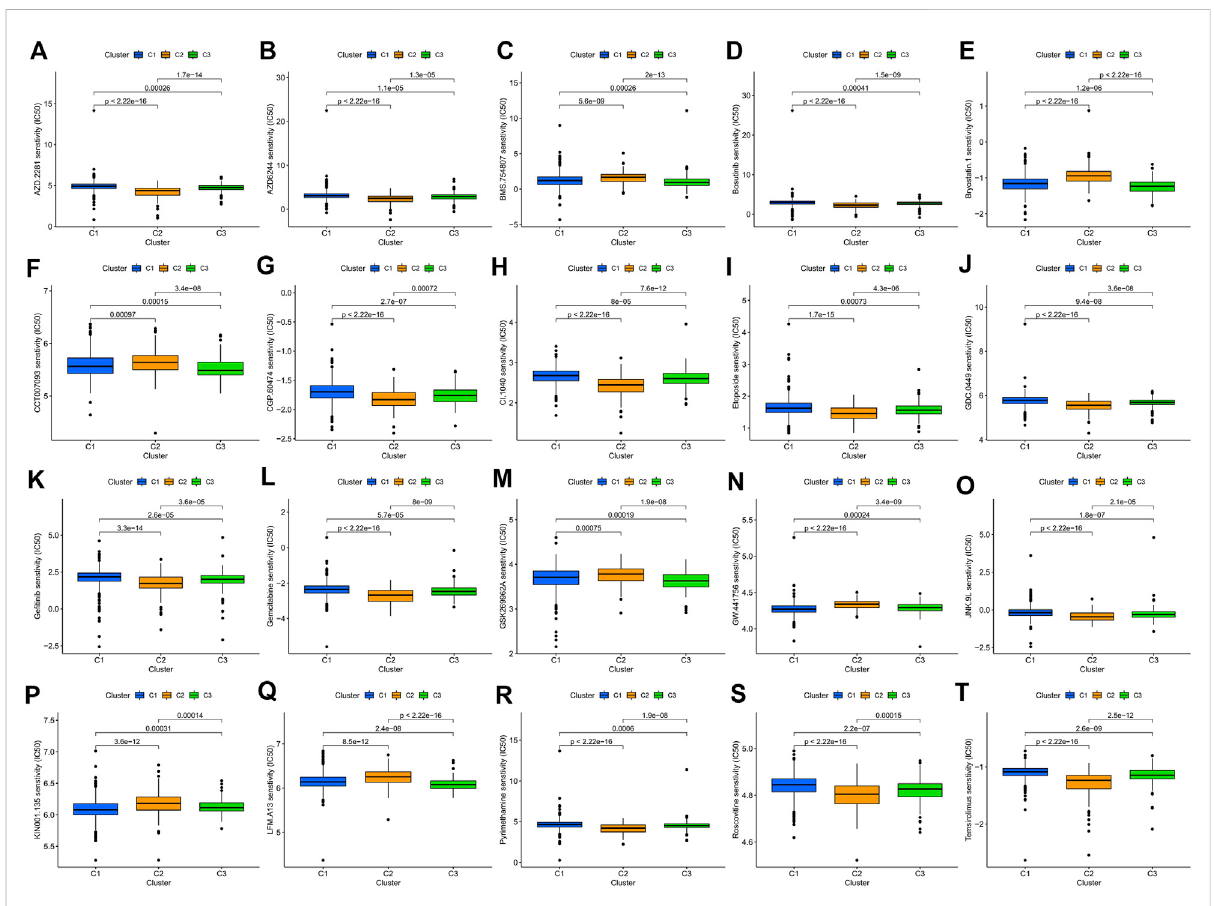
FIGURE 9 Comparison of potential therapeutic drug susceptibility among the three different subgroups as assessed by IC50. (A) AZD.2281. (B) AZD6244. (C) BMS.754807. (D) Bosutinib. (E) Bryostatin.1. (F) CCT007093. (G) CGP.60474. (H) CI.1040. (I) Etoposide. (J) GDC.0449. (K) Ge fi tinib.